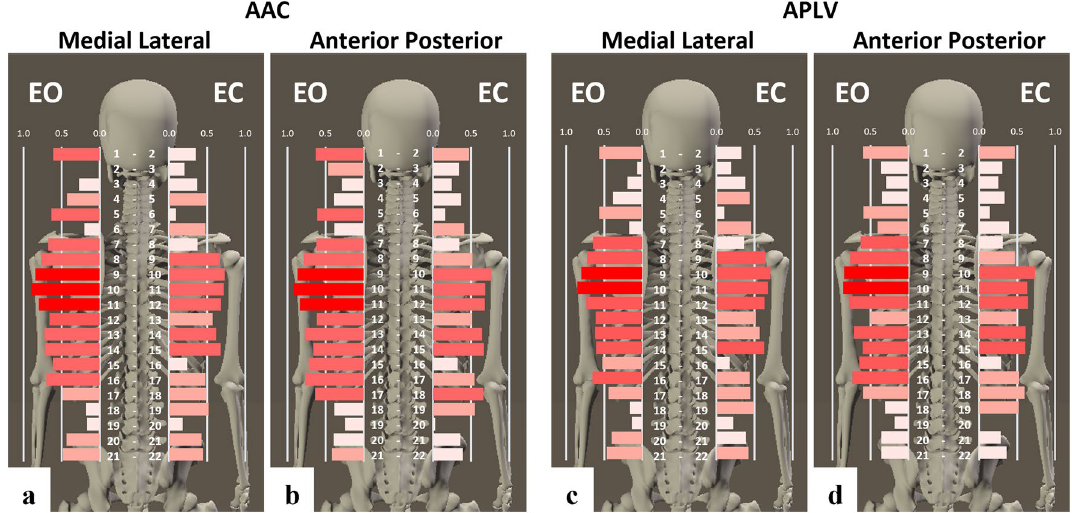
Figure 4. Adaptive segmentation in the head–trunk region with structural redundancy. ACC ( a ) in the medial and lateral directions and ACC ( b ) in the anterior–posterior direction of the adjacent sensors are shown as horizontal bar graphs. APLV ( c ) in the medial and lateral directions and APLV ( d ) in the anterior–posterior direction of the adjacent sensors are shown as horizontal bar graphs. The horizontal axis of the graph shows the AAC and APLV values between the upper and lower sensors. The AAC and APLV values of 21 pairs of sensors from 1 to 22 are shown in order from top to bottom; sensor combinations with high AAC and APLV values are shown in dark red, and sensor combinations with low AAC and APLV values are shown in light red. AAC: average acceleration correlation, APLV: average phase locking value, EO: eye-opening condition, EC: eye-closing